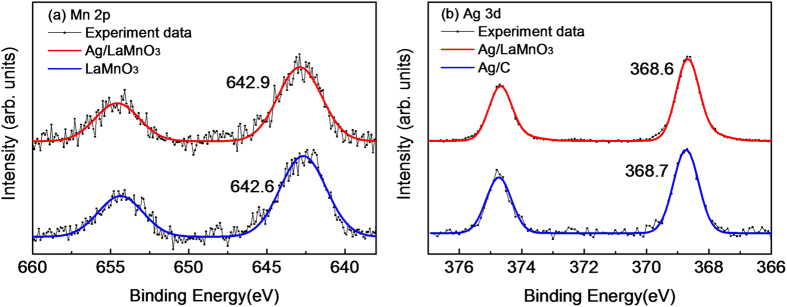
XPS for (a) Mn 2p of Ag/LaMnO3 and LaMnO3, and (b) Ag 3d of Ag/LaMnO3 and Ag/C.